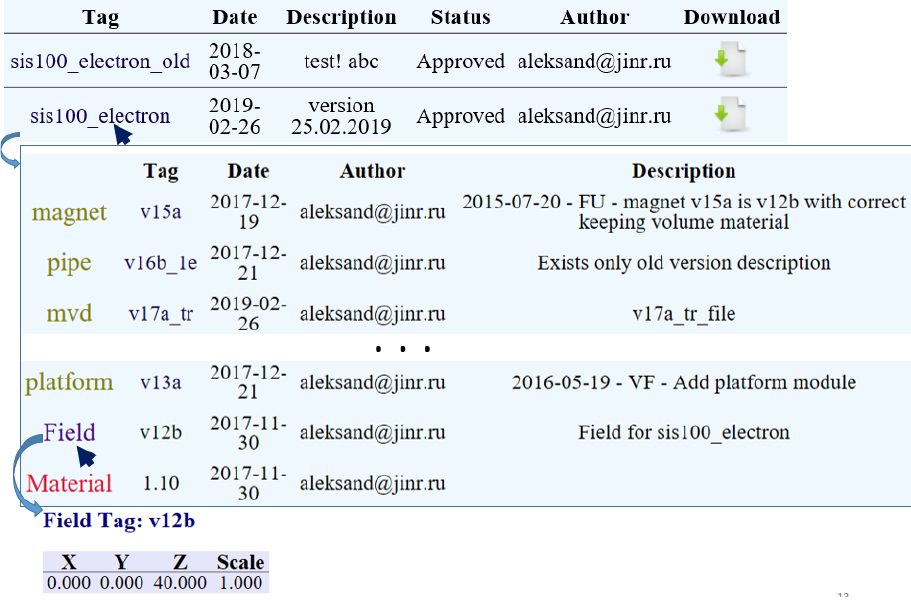
Fig. 5. Web-interface fragment: View Mode.